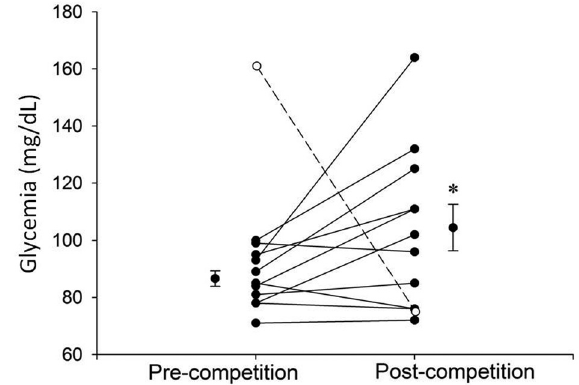
Figure 2 - Capillary glycemia of each athlete before and after a 10-km open-water swimming competition. The white symbol with dashed line shows the only athlete who did not take maltodextrine during the competi- tion. Outer symbols are mean ± SE for the other 11 athletes. * P =0.015 vs. pre-competition data